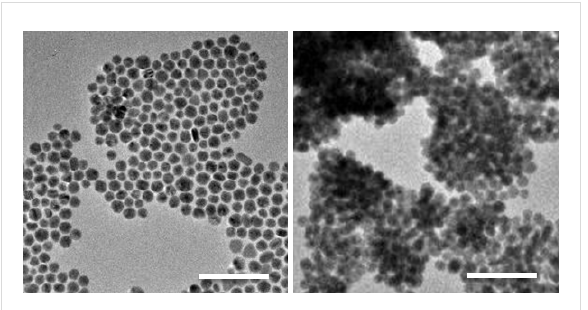
Figure 7: TEM images of a) dispersed and b) agglomerated Au NPs. The scale bars correspond to 100 nm. Adopted with permission from [30]. Copyright 2014 Royal Society of